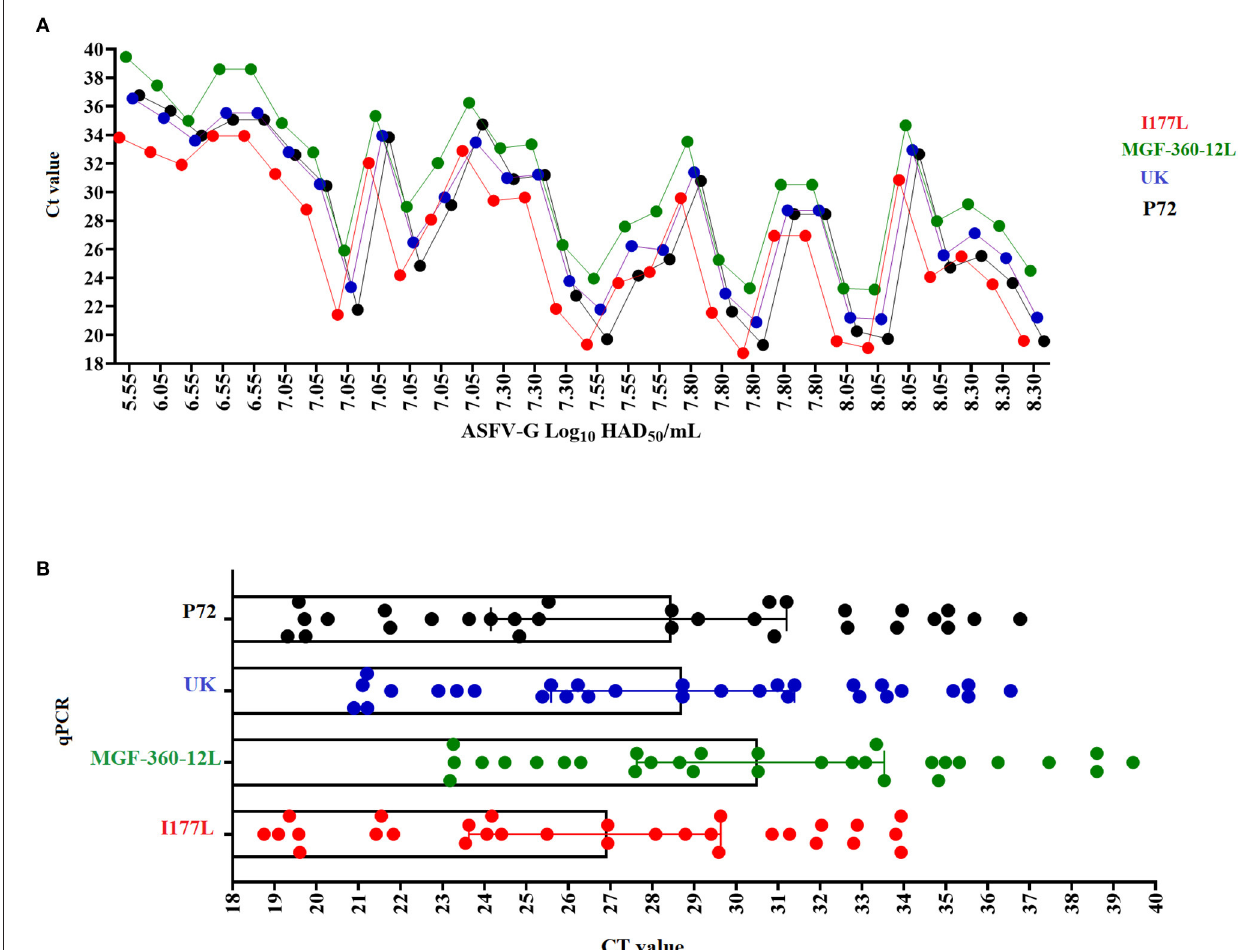
FIGURE 5 | Diagnostic sensitivity. of the different qPCRs assessed using a set of blood samples with different viral titers (expressed in HAD50/ml) collected from pigs experimentally infected with ASFV-G (A) . Comparative average C T values among the different qPCRs in the detection of viremic blood samples obtained from pigs infected with ASFV-G (B) .